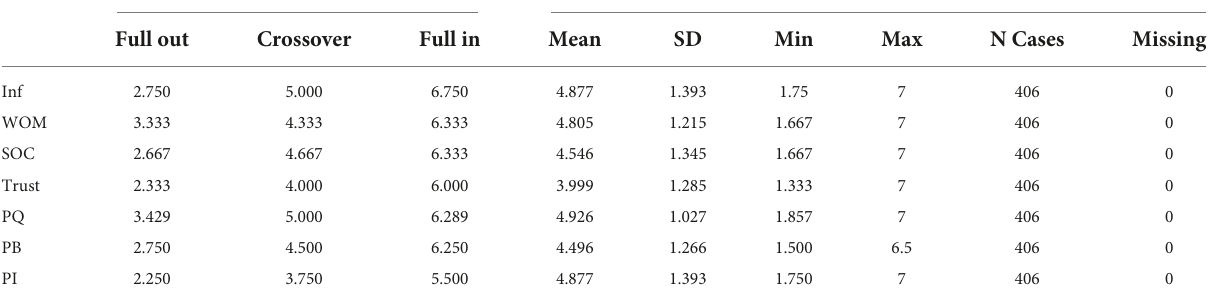
TABLE 2 Sets, calibrations and descriptive statistics.